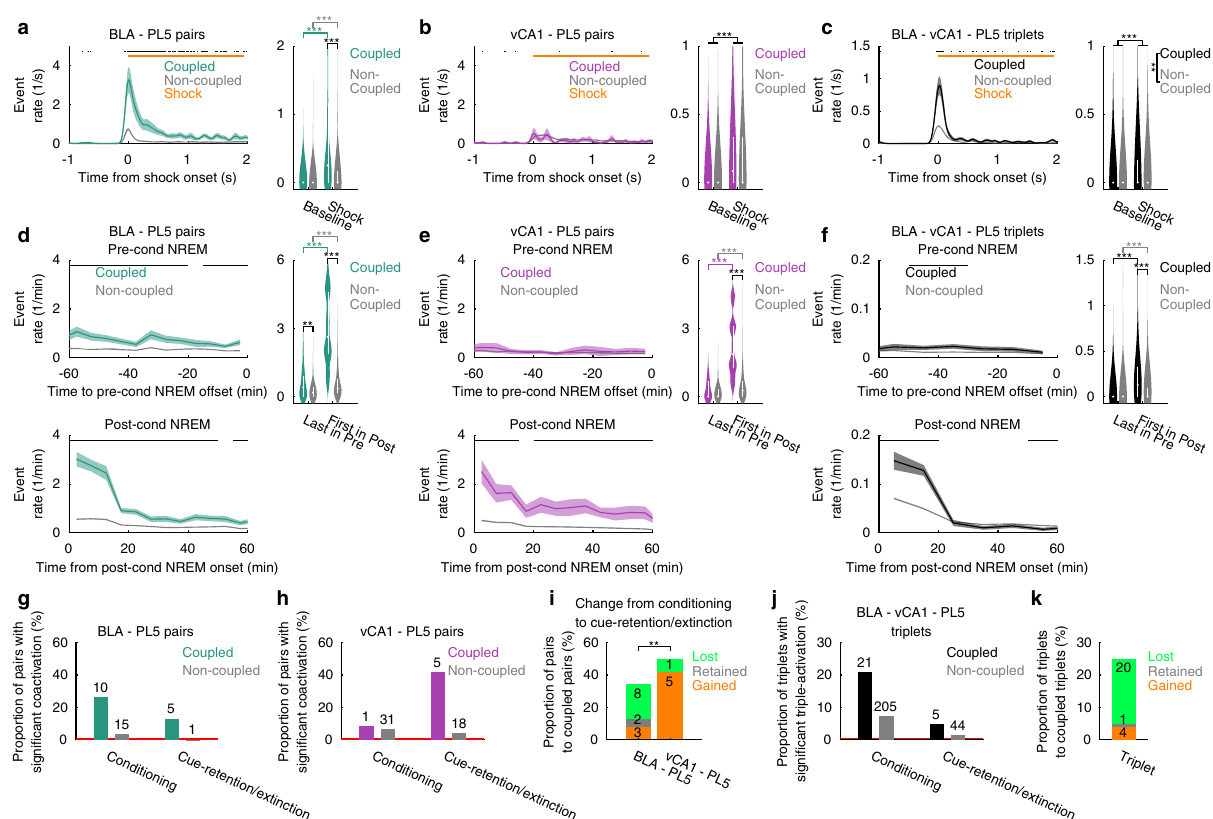
Fig. 7 BLA – PL5 and vCA1 – PL5 ensemble coactivations develop in distinct time courses. a – c Shock-triggered average of coactivation/triple-activation event rates (left) and violin plots representing event rates in periods 0.05 – 0.55s prior to and following shock onsets (baseline and shock, respectively; right). In the left panels, shaded areas represent the SEMs, and black ticks on the top indicate periods with signi fi cant differences ( p <0.05, WSR-test) between coupled- and non-coupled-ensemble-pairs/triplets. In the right panels, white dots and lines represent the median and quartiles, respectively. *** p <0.001, ** p <0.01, post hoc TK test following two-way ANOVA on the ranks. d – f Time-aligned average of coactivation/triple-activation event rates during NREM (left) and violin plots indicating coactivation/triple-activation event rates during last/ fi rst NREM epoch in pre-/post-cond homecage sessions (right). In the left panels, the means were calculated within concatenated NREM epochs during pre- or post-cond homecage sessions. The shaded areas represent SEMs, and the black ticks on the top indicate periods with signi fi cant differences ( p <0.05, WSR-test) between coupled- and non-coupled-ensemble-pairs/triplets. In the right panels, white dots and lines represent median and quartiles, respectively. *** p <0.001, ** p <0.01, post hoc TK test following two-way ANOVA on the ranks. g , h Proportion of BLA – PL5 ( g ) and vCA1 – PL5 ( h ) ensemble pairs that displayed signi fi cant CCG peaks during conditioning and cue-retention/extinction sessions after the fi rst tone onset. Analysed durations of the conditioning and cue-retention/extinction were matched (see “ Methods ” ). The numbers of ensemble pairs are superimposed on the top of the bars. Red horizontal bars indicate the chance level (0.5%). i Proportion of coupled-ensemble-pairs that gained, retained, or lost signi fi cant CCG peaks from conditioning sessions to cue-retention/extinction sessions. ** p <0.01, Fisher ’ s exact test. The number of pairs is superimposed on the bars. j , k Same as ( g – i ) but for BLA – vCA1 – PL5 triplets. Ensembles were detected based on neuronal fi rings in entire conditioning sessions and divided into coupled- and non-coupled-ensemble-pairs/triplets based on their coactivation/triple-activation in post-cond NREM. The numbers of ensemble pairs and triplets analysed are summarised in Supplementary Table 4. Detailed statistics are shown in Supplementary Data 1. Source data are provided as a Source Data fi